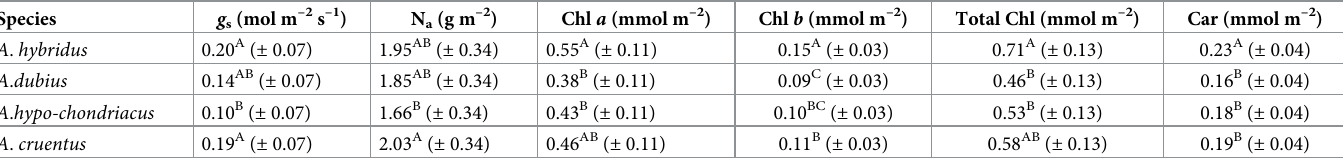
Table 3. Mean comparison (Tukey Honest Significant Difference) and 95% confidence intervals of amaranth species for stomatal conductance ( g s ), nitrogen content per unit area (N a ), chlorophyll (Chl), and carotenoids (Car) contents. n = 24 ( g s ), n = 48 for the rest of the traits.